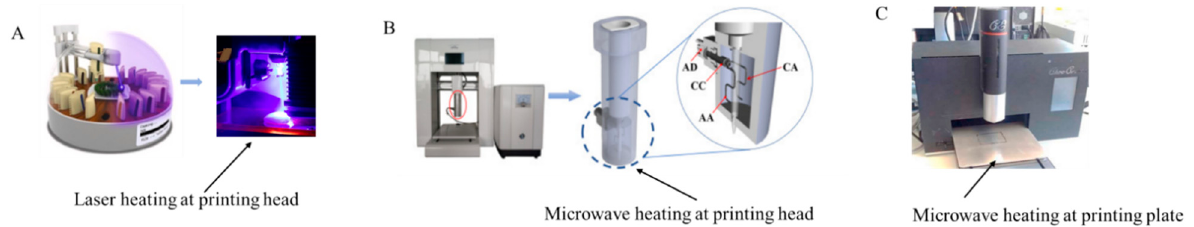
Figure 3. Examples of an existing integration device including printing and heating ( A ) laser heating ( B ) microwave heating at printing head ( C ) microwave heating at printing plate (Reprinted with permission from Hall et al., [80]. © 2021, Frontiers Ltd., Lausanne, The Switzerland.)